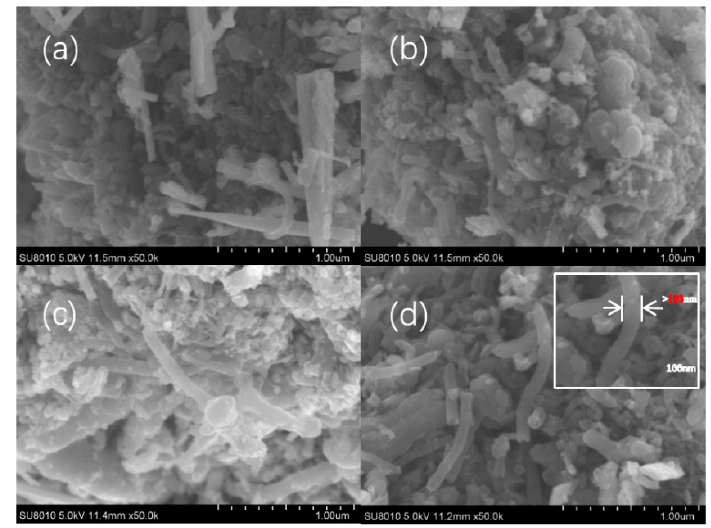
Figure 3. SEM images of the Mo–Bi BMC@CNTs nanocomposites with different CNT contents ( a ) 10%, ( b ) 15%, ( c ) 20%, ( d ) 25%.